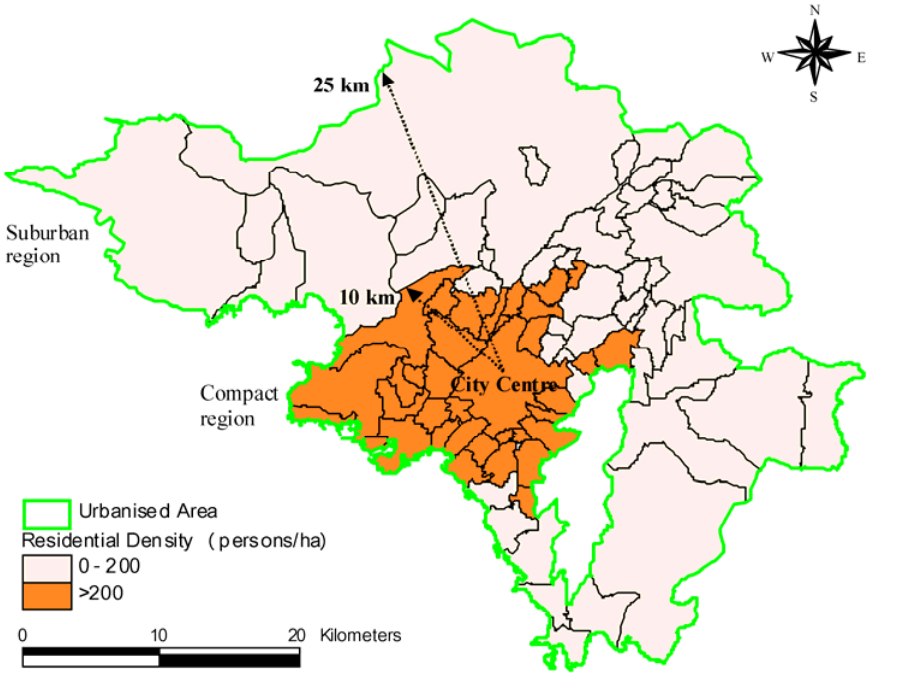
Figure 3. The compact and suburban regions in Athens, defined by a density threshold of 200 persons/ha.